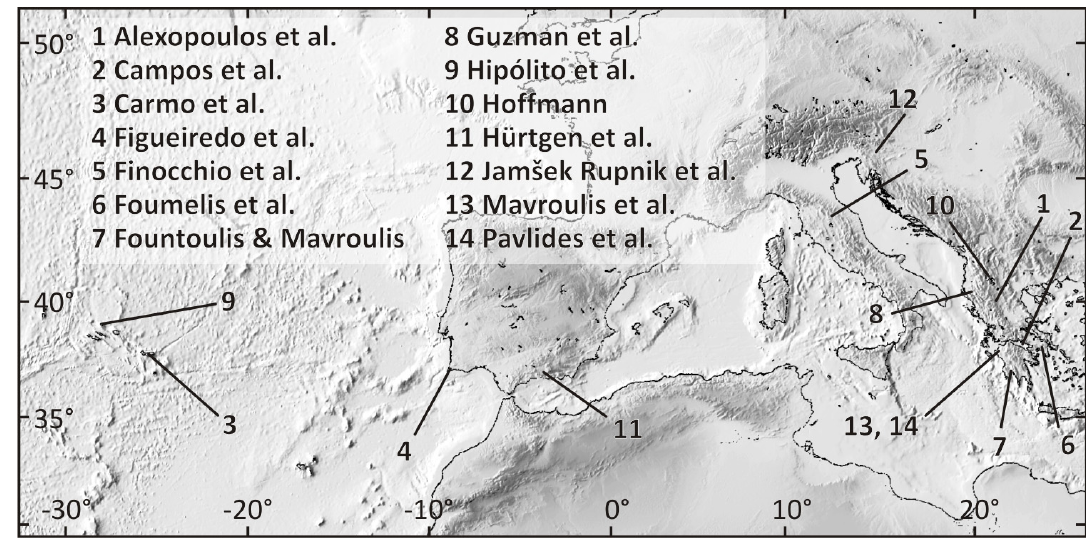
Figure 1. The study sites of the papers included in this special